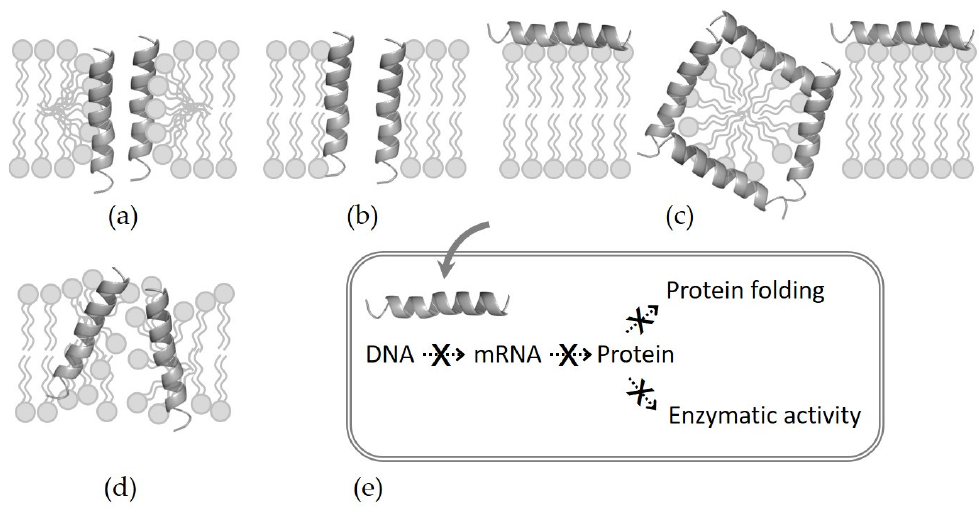
Figure 1. Action mechanisms of AMPs. ( a ) Barrel–stave model, ( b ) toroidal pore model, ( c ) carpet model, ( d ) aggregate model, and ( e ) inhibition of vital cell processes after passing through the bac- terial